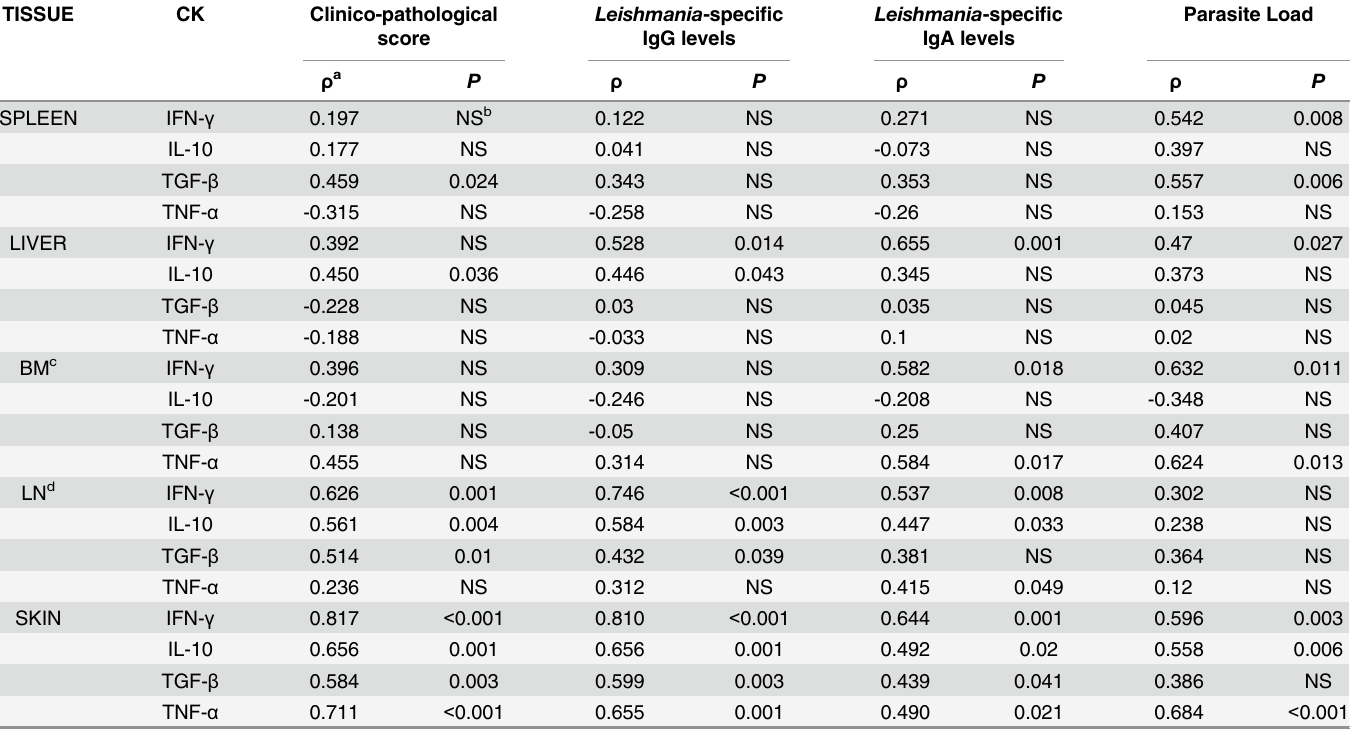
Table 2. Relationships amongst cytokine expression in different target organs and clinicopathological score, Leishmania -specific IgG and IgA lev- els, and parasite load.